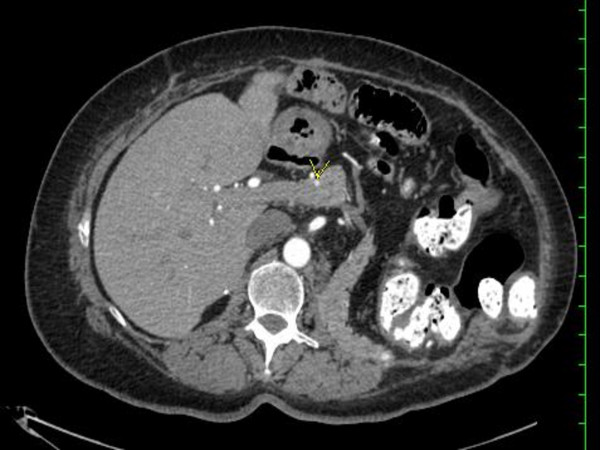
Radiological evaluation. A computed tomography of the chest and abdomen demonstrated multiple small enhancing nodules throughout the pancreas.